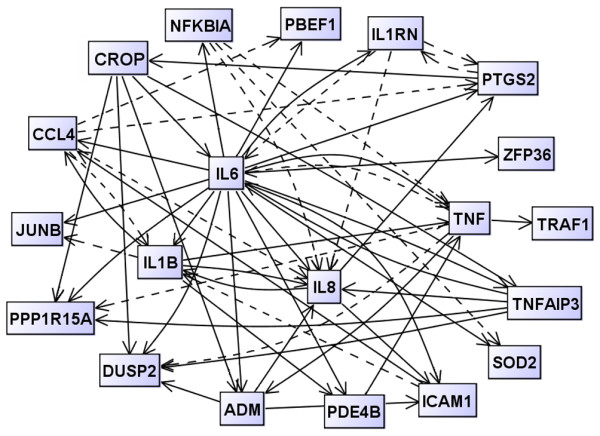
Visualization of the inferred dynamic gene regulatory network for the responder group. Each gene is represented by a node, and gene regulatory interactions are shown by directed edges. Solid lines, activating effects; dashed lines, inhibitory effects. The hypothesized network was reconstructed from quantitative real-time RT-PCR data by the modified LASSO method.